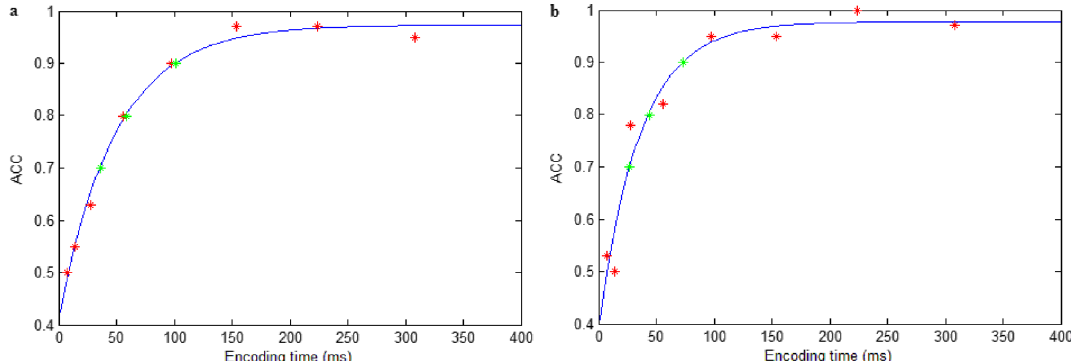
Figure 3. Results of fitting the psychometric function to samples in Experiment 1 ( a ) and 2 ( b ). The red stars show the accuracy at different encoding time intervals in the pretest task. The continuous blue lines illustrate the function fits. The green stars show the expected duration that produced ~ 70%, ~ 80%, and ~ 90% twice the corresponding time of ~ 90% correct [2 × T(90%)] and quadruple the corresponding time of ~ 90% correct [4 × T(90%)]) and followed by a mask (200 ms). The corresponding time of different accuracies was cal-